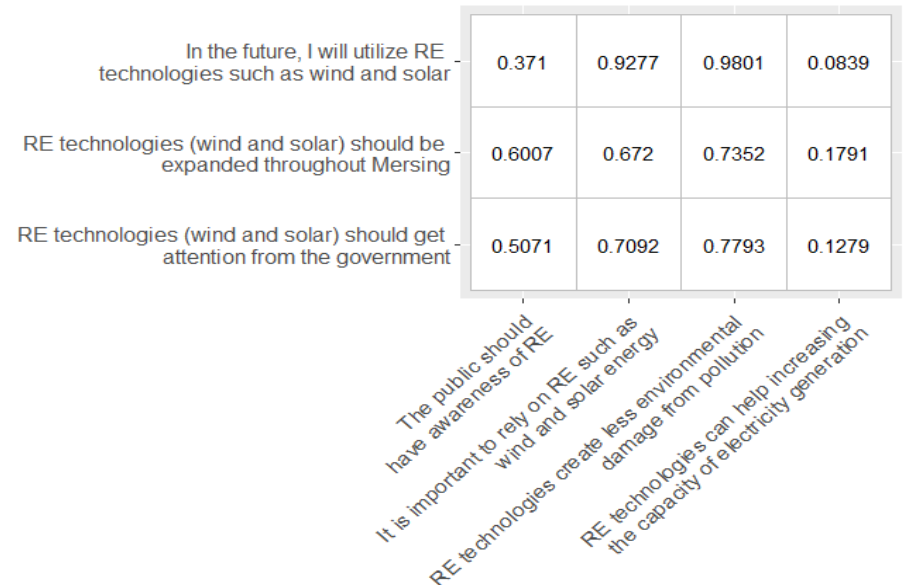
Figure 16. Correlation between items in knowledge and awareness of RE and desire and acceptance of RE.